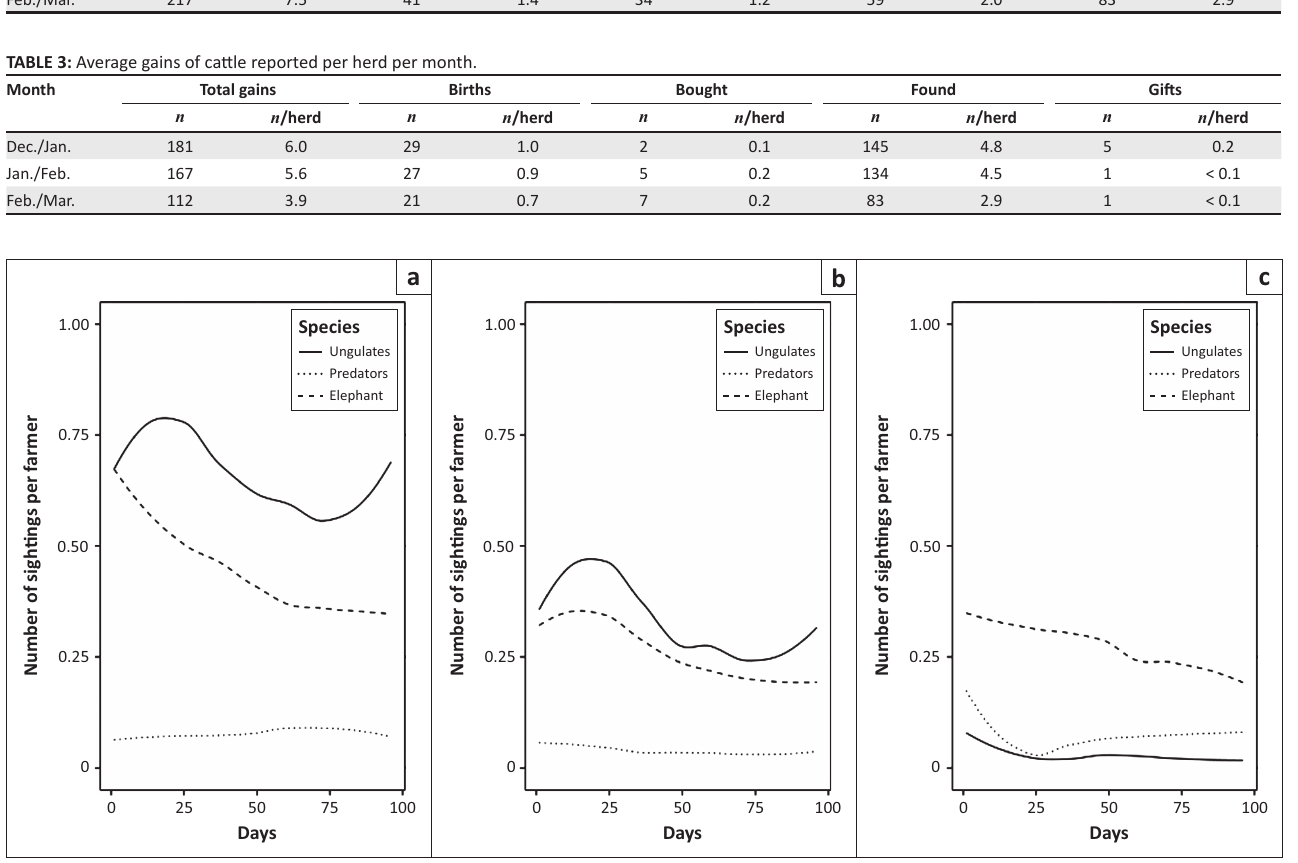
TABLE 2: Average losses of cattle reported per herd per month. Month Total losses Deaths Sold Lost Theft Dec./Jan. Jan./Feb. Feb./Mar.